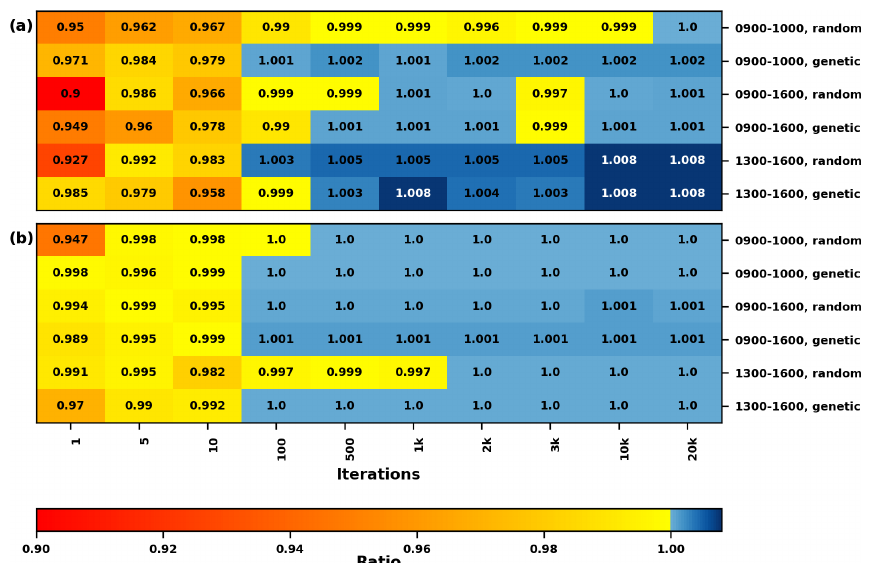
Figure 9. Heat maps showing the ratio of potential decrease in T mrt between the hill-climbing algorithm and the greedy algorithm for (a) five small trees with different time steps and (b) five large trees with different time steps, on 22 June 1983 (see Table 1 for detailed tree sizes). Two starting algorithms were used: random and genetic. There are 1709 potential locations for small trees and 1481 for large trees. A ratio > 1 indicates a larger potential decrease with the hill-climbing algorithm. Table 3. Table showing difference in average T mrt ( ◦ C) between the SOLWEIG simulation without new trees and the SOLWEIG simulation with new trees and recalculated SVF for the two algorithms, different tree sizes, different time periods and number of trees. The differences in T mrt are for the shaded area (m 2 ) of the new trees ( ◦ C) with corresponding shadow area (m 2 ) and decrease per shaded pixel, and decrease for the entire raster ( ◦ C) with corresponding canopy area (m 2 ) and decrease per canopy area ( ◦ Cm − 2